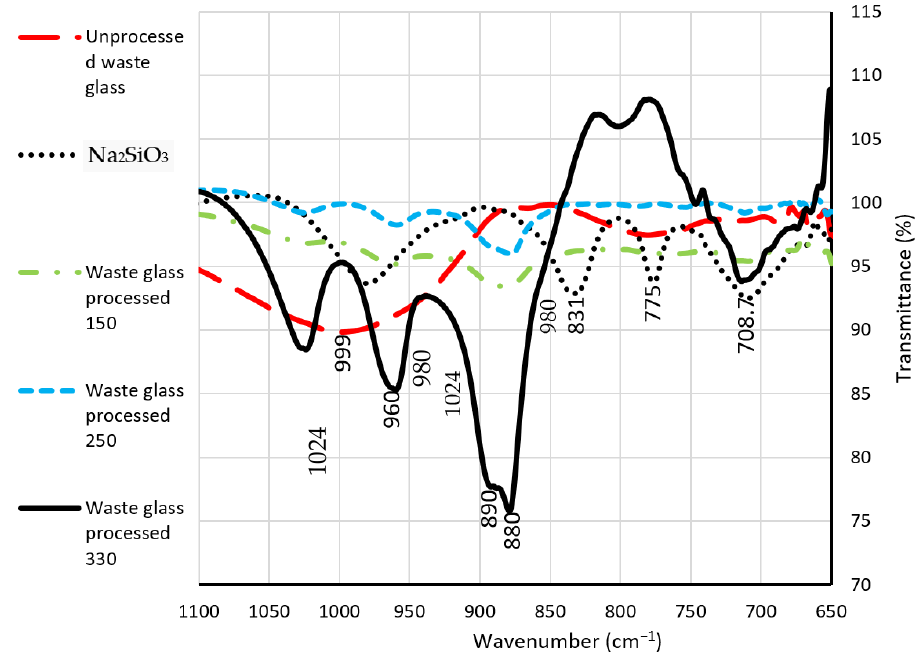
Figure 1. Detail of the 1100–650 wavenumber range for FTIR of commercially available Na 2 SiO 3 , unprocessed waste glass powder and the processed ones at 150, 250 and 330 °C.